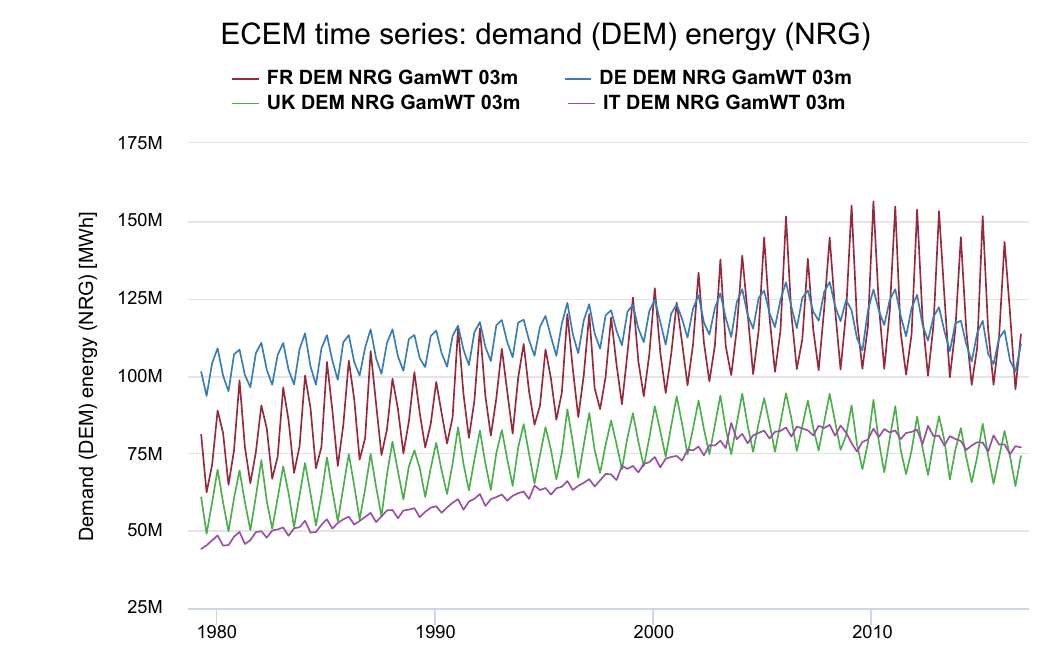
Figure 3. Example of seasonally averaged electricity demand (in MWh) plot for France (burgundy), Germany (blue), United Kingdom (green) and Italy (purple). This plot has been produced by, and downloaded from, the ECEM Demonstrator (http://ecem.climate.copernicus. eu/demonstrator/, last access: 3 July